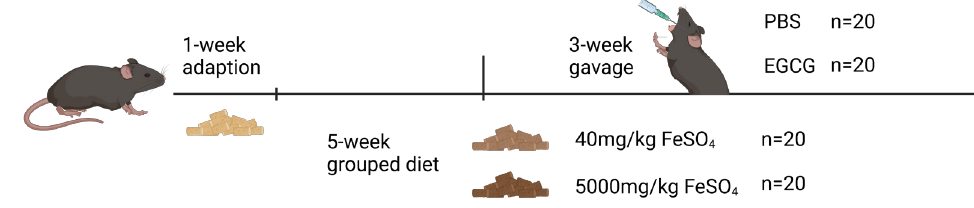
Figure 1. Timeline of the animal experiment. The test mice were divided into four groups as follows. control group: 40 mg/kg FeSO 4 + PBS; EGCG